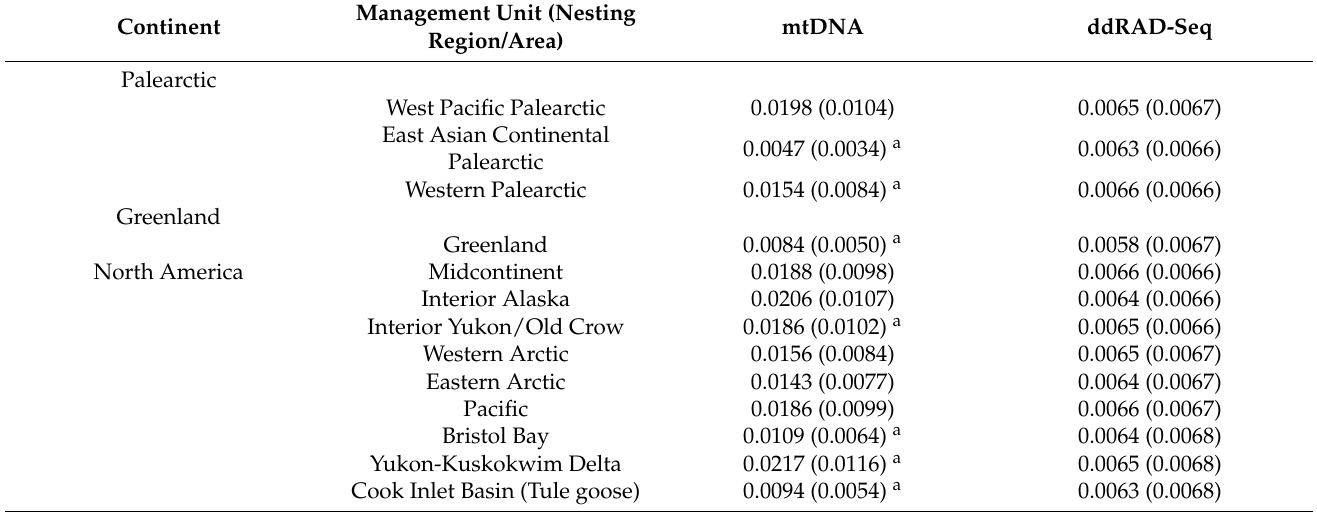
Table 3. Nucleotide diversity for the mtDNA control region (this study and [35]) and 3888 ddRAD-seq loci for management units and subpopulations within the Midcontinent and Pacific Units. Standard deviations are in